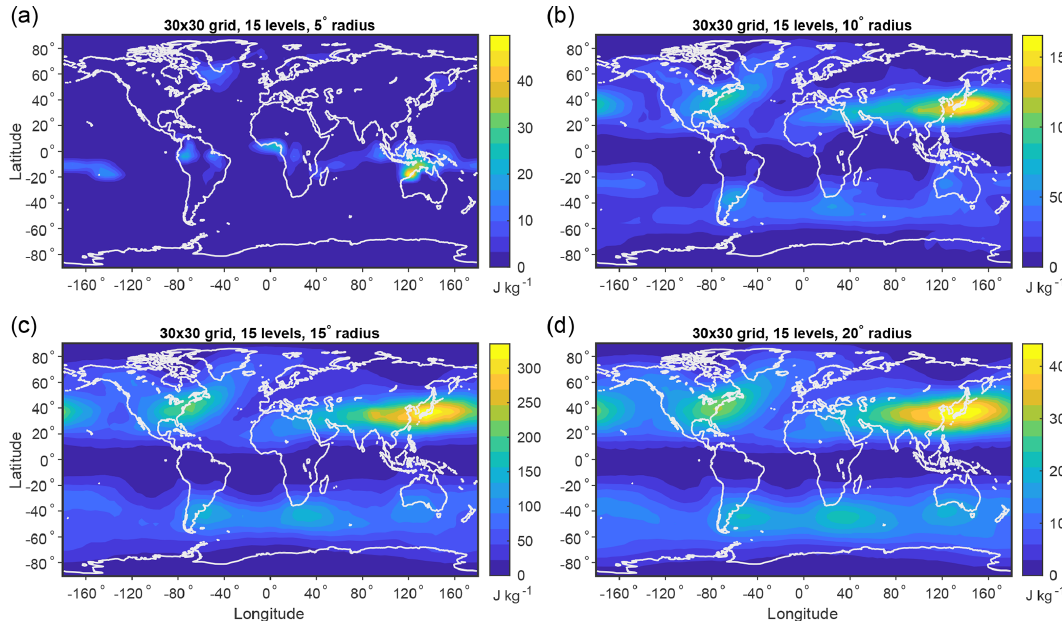
Figure B3. Local MAPE based on the DJF climatological mean over 1979–2018 using subdomains of varying geodesic radii: (a) 5 ◦ (560km), (b) 10 ◦ (1110km), (c) 15 ◦ (1670km), and (d) 20 ◦ (2230km). All results in this figure use 1800 surface grid cells (a 30 × 30 grid in each hemisphere) and 15 pressure levels.